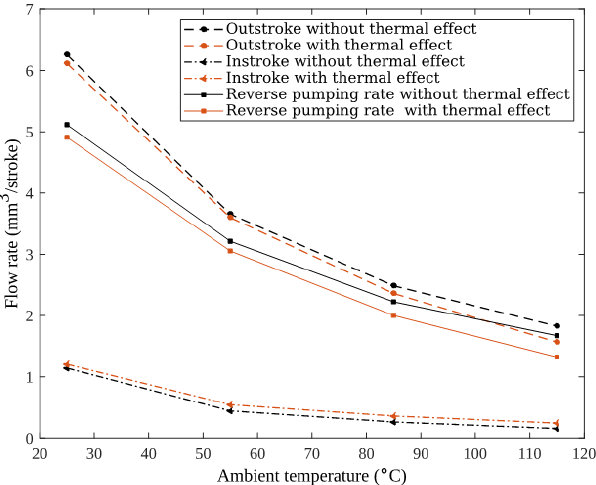
Figure 10. Variation in flow rate according to different ambient temperatures and whether thermal effects are considered .